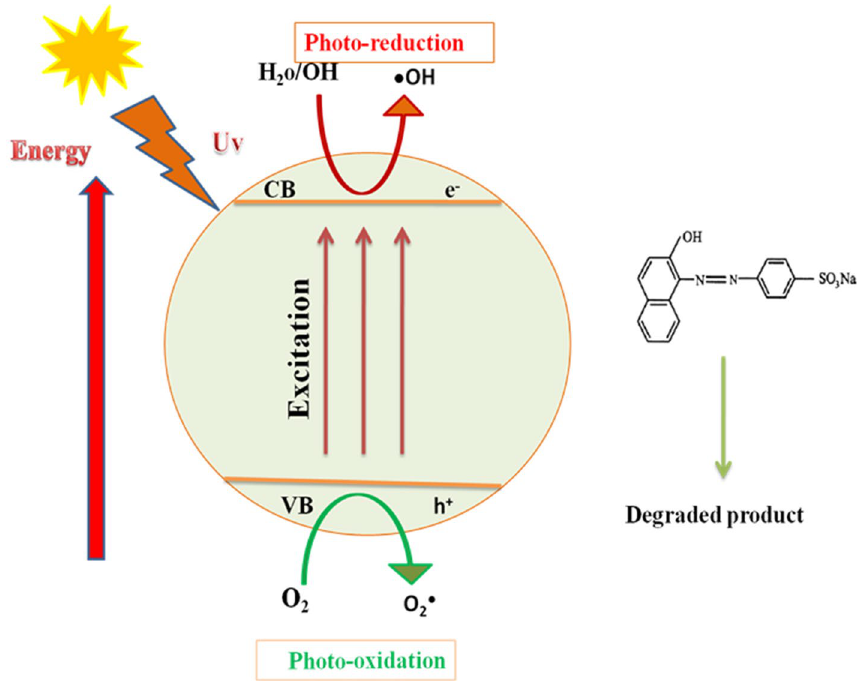
Fig. 8 Proposed mechanism for photodegradation of O II dye by NiO